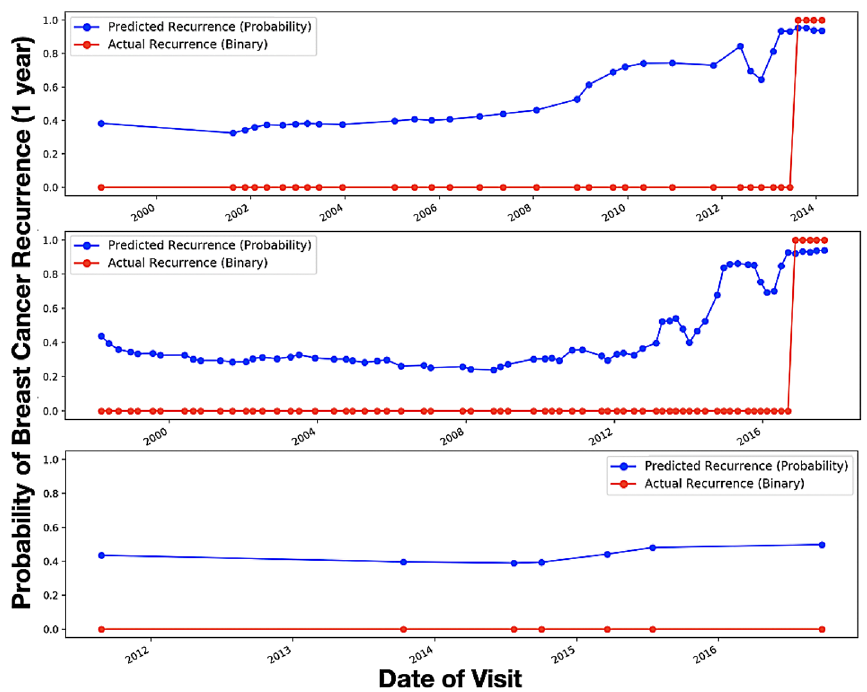
Figure 4. Predicted recurrence probability plotted against the actual recurrence status over time for three separate patients—x-axis shows the encounter date in ascending order starting from the first visit, y-axis shows the probability. Red line represents the ground truth: Definite recurrence = 1, No Recurrence = 0. Blue line represents the predicted probability